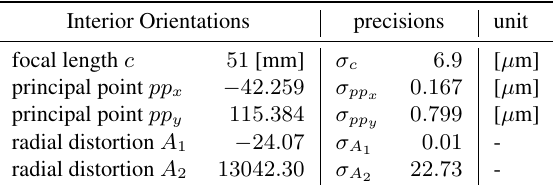
Table 6. Interior Orientations and their